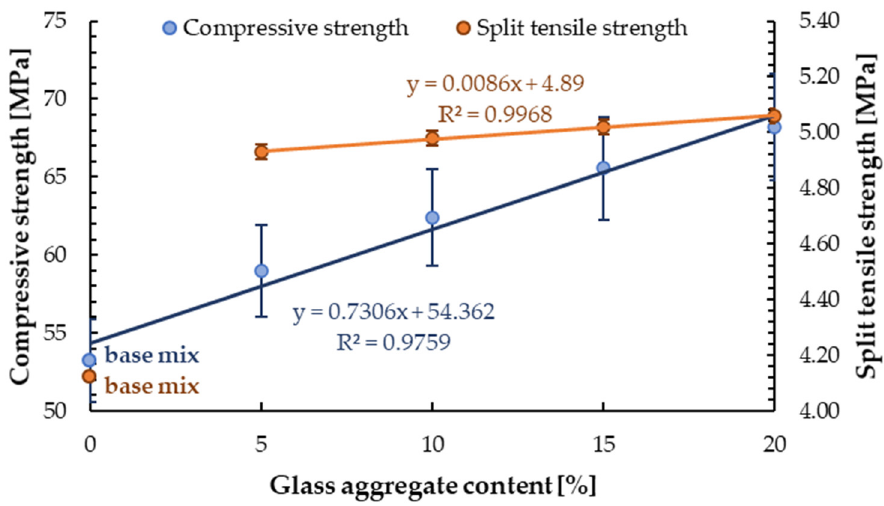
Figure 9. Compressive and split tensile strength of samples with GSA depending on GSA content.